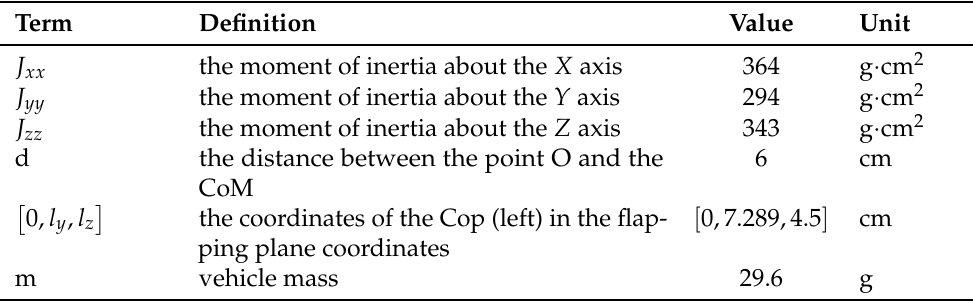
Table 1. Parameters of the FMAV’s dynamic model.